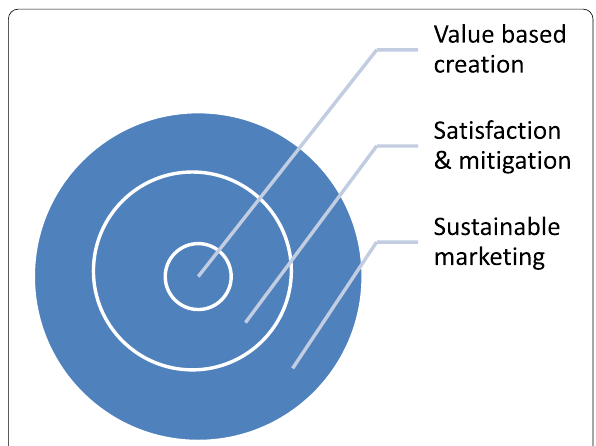
Fig. 3 Proposed Model of Sustainable Marketing: ‘Appendix 1 in Fig. 4 as titled, and shown; “Proposed Model of Sustainable Marketing” emphasizes value creation and core values in propensity towards mitigation and satisfaction in respect to the environment and consumers or customers respectively